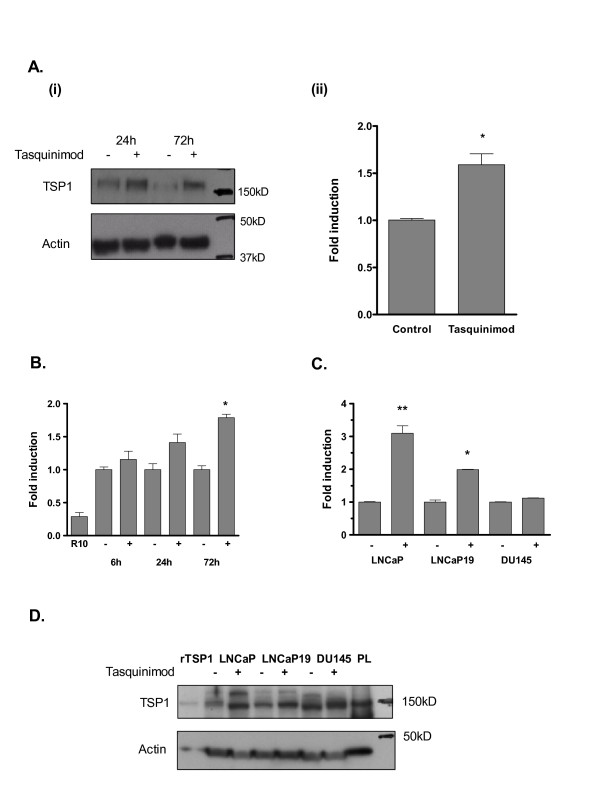
TSP1 expression by LNCaP cells after tasquinimod exposure in in vitro cell cultures. (A) Up-regulation of the TSP1 protein levels by tasquinimod (50 μM) in LNCaP cells was measured by western blot analysis (left panel (i)). Protein bands represent intact TSP1 at ~160 kD (monoclonal Ab11). TSP1 secreted into cell culture medium was measured with ELISA after 72 h (right panel (ii)). The culture medium levels of TSP1 were 50.8 ± 1.5 ng/ml for untreated cells and 80.6 ± 10.2 ng/ml for exposed cells, respectively (n = 3; p ≤ 0.05, ANOVA). (B) TSP1 secretion into cell culture medium after exposure of LNCaP cells to 10 μM tasquinimod (+) (p ≤ 0.01, ANOVA). TSP1 levels in untreated (-) cell culture medium were 22, 36.6 and 51.6 ng/ml after 6, 24 and 72 h incubation, respectively, and 6 ng/ml in the R10 medium. (C) Up-regulation of TSP1 mRNA levels occurred in the hormone independent prostate cancer cell line LNCaP19 but not in DU145, (-) untreated control and (+) 10 μM tasquinimod (p ≤ 0.0001; ANOVA). Presented data represent the mean ± SD of at least two independent experiments. (*) p ≤ 0.05 and (**) p ≤ 0.01 compared with untreated control (Bonferroni's multiple comparison test). (D) TSP1 protein levels measured by western blot analysis of prostate cancer cell lysates, (-) untreated control and (+) 10 μM tasquinimod for 72 h. PL indicates lysate prepared from human platelets and rTSP1 is recombinant TSP1.